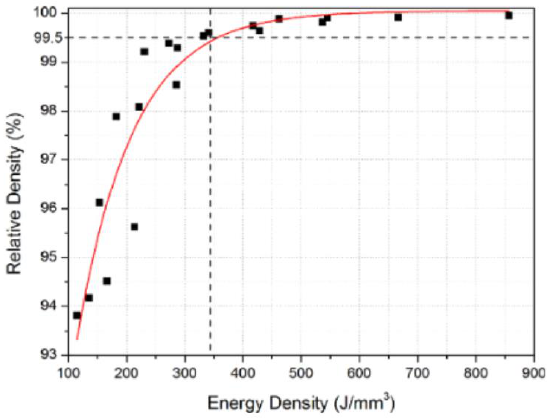
Figure 4. Relative density of Al-Cu-Mg sample with respect to laser